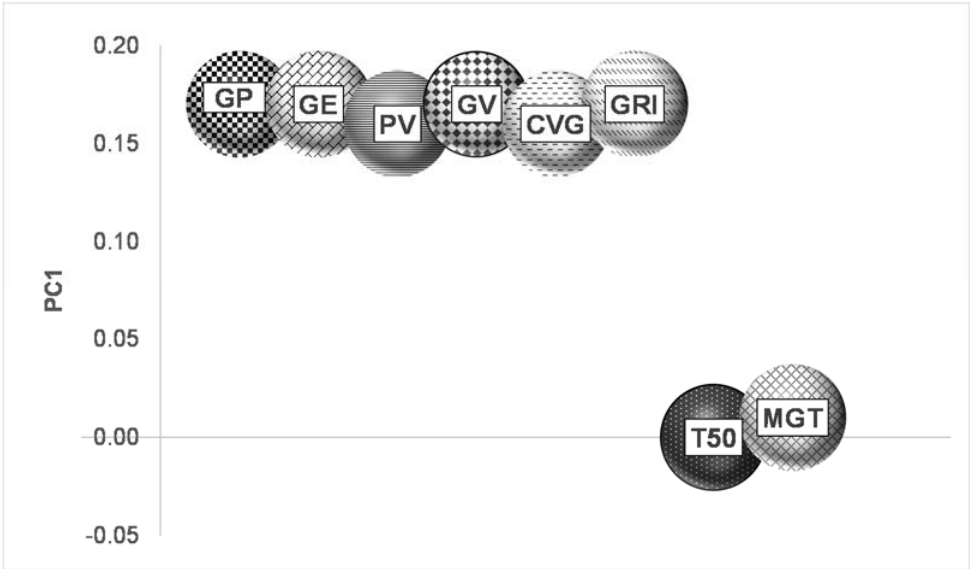
Figure 3. Contribution of the studied variables to the first principal component (PC1) of Salicornia europaea seeds exposed to salt stress. GP, germination percentage; GE, germination energy; PV, peak value; GV, germination value; GRI, germination rate index; CVG, coefficient of velocity of germination; T 50 , time to reach 50% germination; MGT, mean germination time.